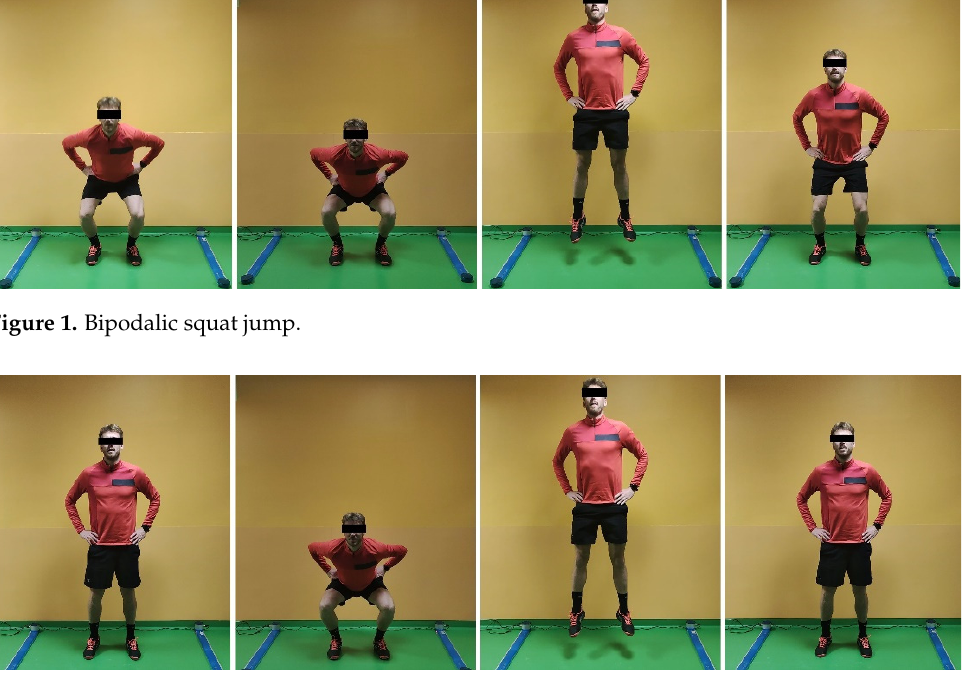
Figure 3. Monopodalic countermovement jump. Figure 4. Monopodalic side hop test. 2.4. Statistical Analysis Statistical analyses were performed using Graphpad Prism v8.0 (Prism software, La Jolla, San Diego, CA, USA). Shapiro–Wilk test was used to test the distribution of each variable. In case of normal distribution, paired Student t tests were used to assess differ ‐ ences between pre ‐ operative and 6 ‐ month values. Patients were dichotomized by post ‐ operative ACL ‐ RSI score into two groups: group A (ACL ‐ RSI > 60), and group B (ACL ‐ RSI < 60); unpaired t test were used to evaluate differences between the two groups. In case of non ‐ normal distribution, the same assessments were performed by Wilcoxon signed ‐ rank test for matched pairs and Mann–Whitney U test, respectively. Difference be ‐ tween proportions were assessed by Fisher’s exact test. p values < 0.05 were considered statistically significant. Post ‐ hoc power analysis was performed for the test evaluating the improvements in Lysholm, ACL ‐ RSI, and IKDC after surgery. For a test with alpha = 0.05, the study sample size provided a test power > 90% for each score.